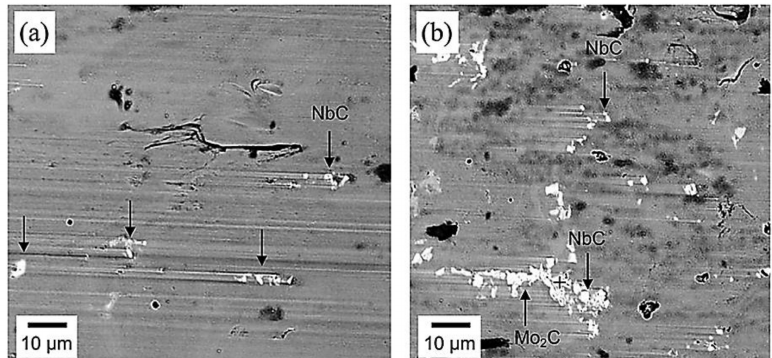
Figure 16. Morphological structures of wear tracks in niobium-alloyed ADI showing ( a ) the impedi- ment of ploughing by distributed niobium-carbon particles and ( b ) big eutectic carbides produced by molybdenum separation in the interfacial region [41].